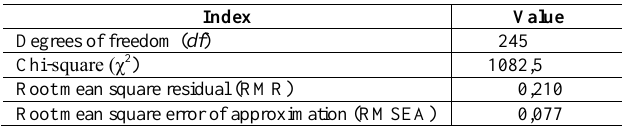
Table 5: Goodness-of-fit